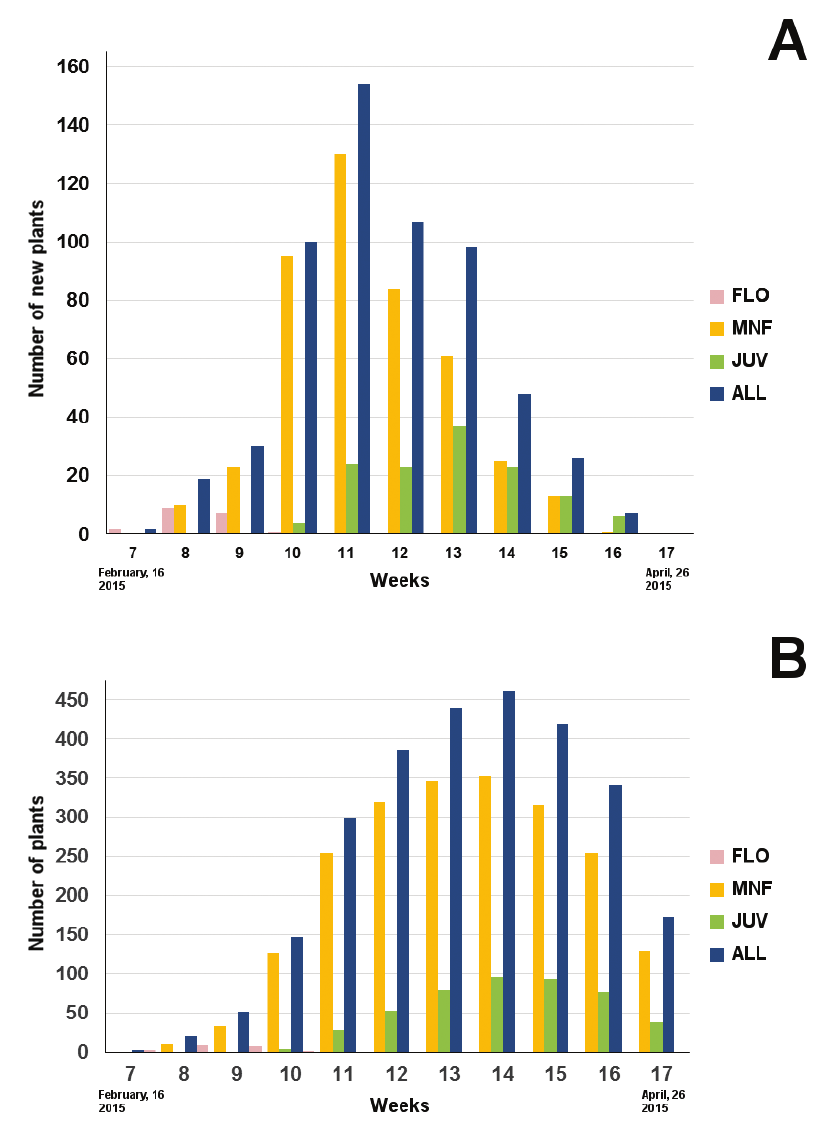
Figure 1. Number of individuals of Erythronium dens-canis during spring 2015 in Farneto-C . The histograms show the number of flowering (FLO), mature non-flowering (MNF) and juvenile (JUV) plants. A New plants and B all